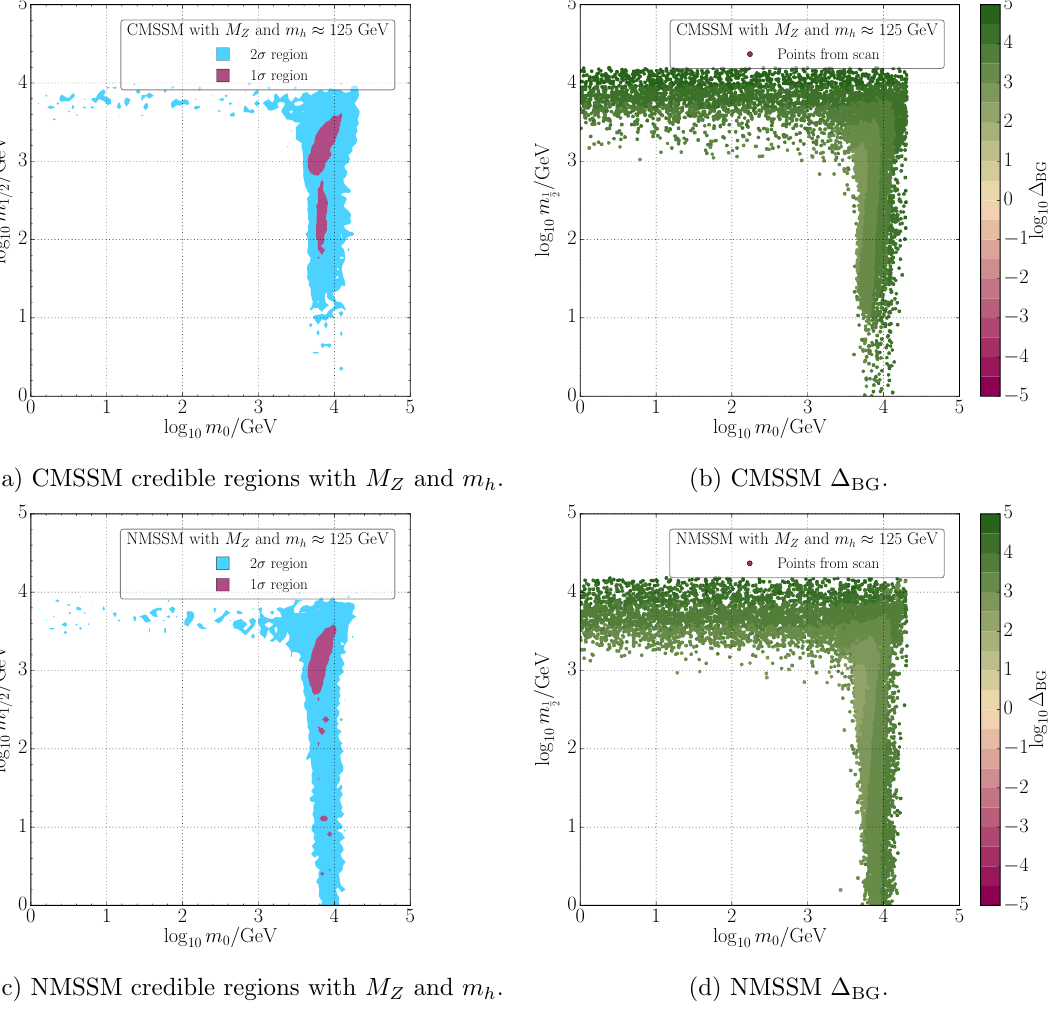
Figure 5. Credible regions of the marginalized posterior probability density conditioned upon M Z and m h (left), and pro(cid:12)led BGEN measure (right) for the CMSSM (upper) and NMSSM (lower) on the ( m 0 , m ) 1 = 2